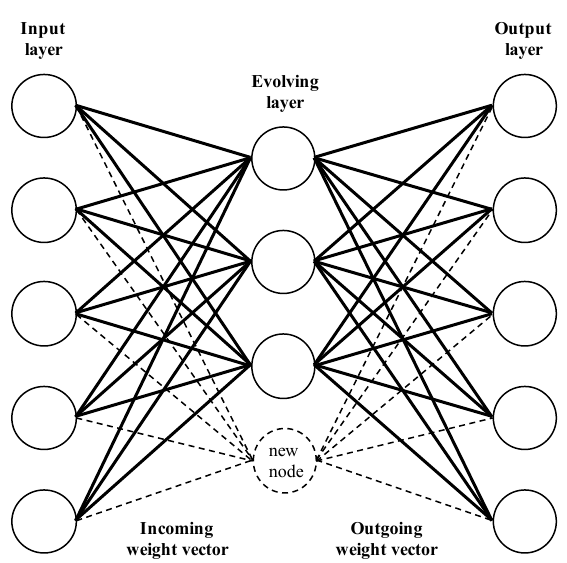
Figure 2. Graphical description of the SECoS network. Adaptation of the general ECoS representation from Watts [29].